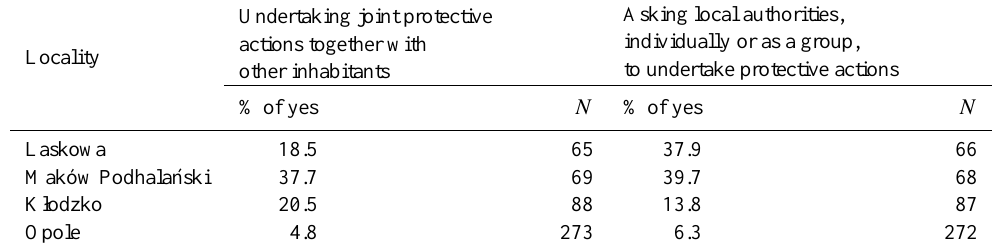
Asking local authorities, individually or as a group, to undertake protective